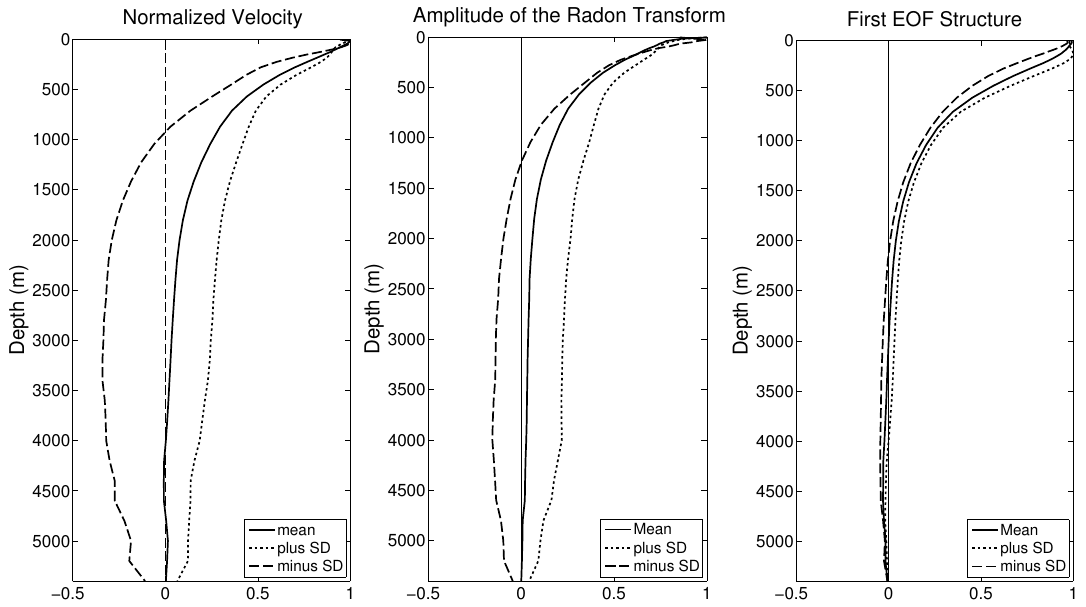
Fig. 4. Normalized vertical profiles from the model data with their normalized ± 1 standard deviation (SD) profiles. (a) The normalized velocity method, (b) the amplitude of the Radon transform method and (c) the EOF